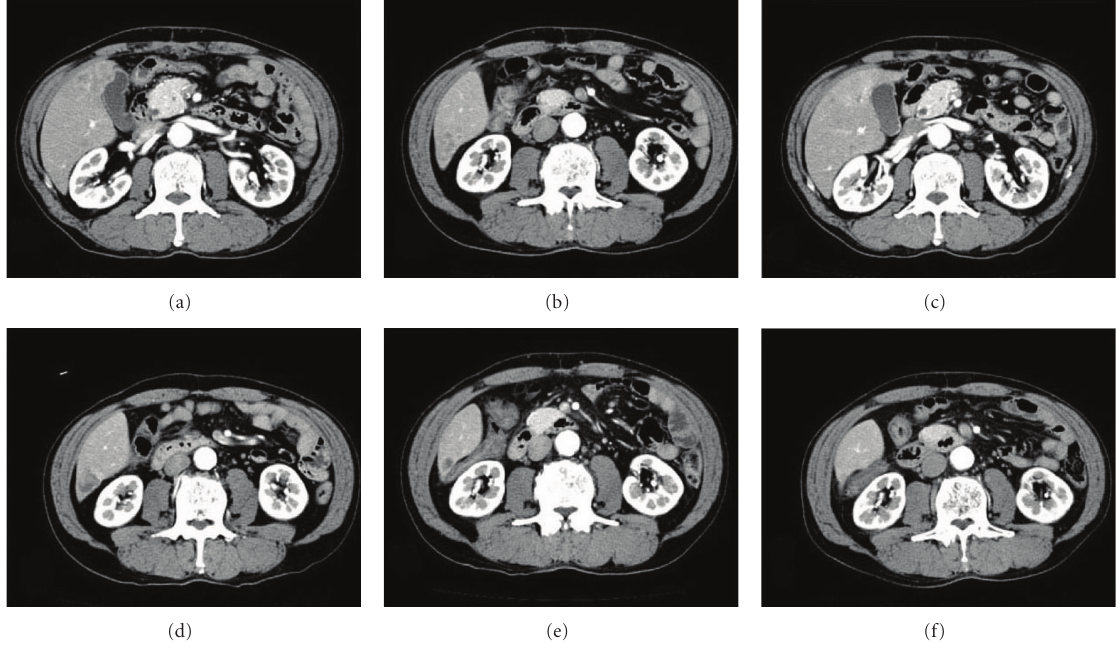
Figure 2: Abdominal computed tomography (CT) findings. (a)-(b) CT scan before chemoradiotherapy showing multiple liver metastases in S5 and S6. (c)-(d) CT scan after 5 cycles of S-1 administration showing disappearance of the tumor in S5, while tumor was still visible in S6. (e) CT scan after radiation and 10 cycles of S-1 administration showing reduction of tumor in S6. (f) CT scan after radiation and 15 cycles of S-1 administration showing disappearance of liver metastasis; hence, this case was interpreted as a complete